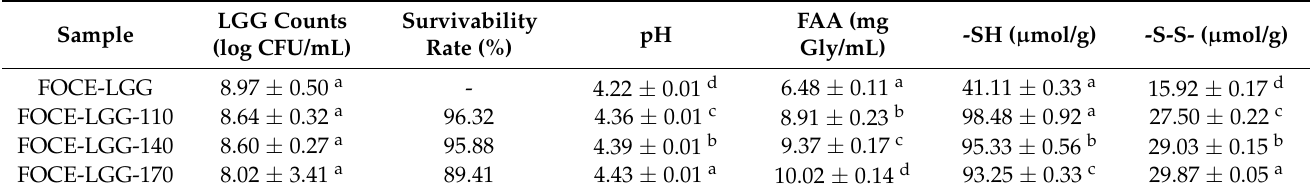
Values are means ± standard deviation of triplicate determinations. Means with different letters in the same column are significantly different at p <